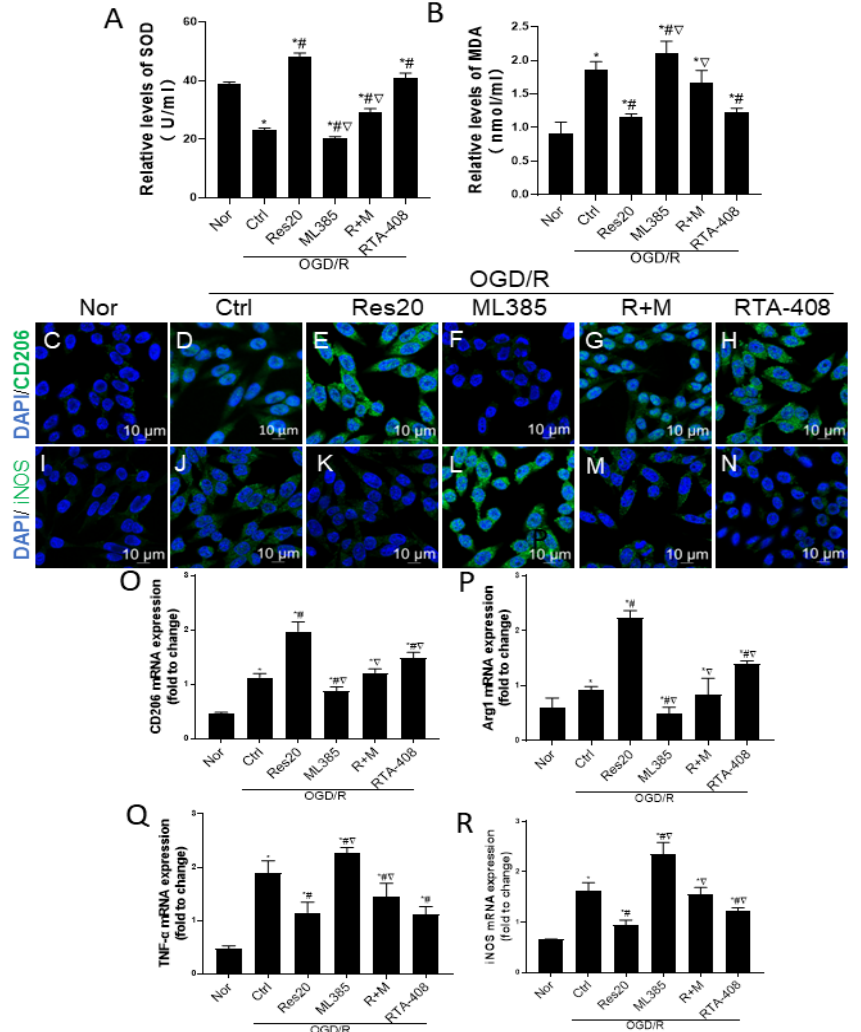
Figure 4. Nrf2 signaling mediates the effects of resveratrol to inhibit oxidative stress and regulate M1/M2 phenotype polarization of microglia following OGD/R injury in vitro . ( A ) SOD activity de- tected by WST-1 assay. ( B ) MDA level detected by TBA assay. ( C-H ): merges of immunofluores- cence staining CD206 (green) and DAPI (blue); ( I – N ): merges of immunofluorescence staining iNOS (green) and DAPI (blue); Scale bars =10 um. ( O – R ): the expression levels of CD206, Arg1, iNOS and TNF- α mRNA with RT -PCR; * p < 0.05 vs. Nor; # p < 0.05 vs. Ctrl; ▽ p < 0.05 vs. Res20. Data are presented as the mean ± standard deviation and were compared using a one-way analysis of vari- ance ( n = 3 for each group). Nor, normal; Ctrl, control; Res20, 20 μM resveratrol, ML385, Nrf2 inhib- itor; R+M, 20 μM resveratrol combination with ML385.RTA-408, Nrf2 agonist.